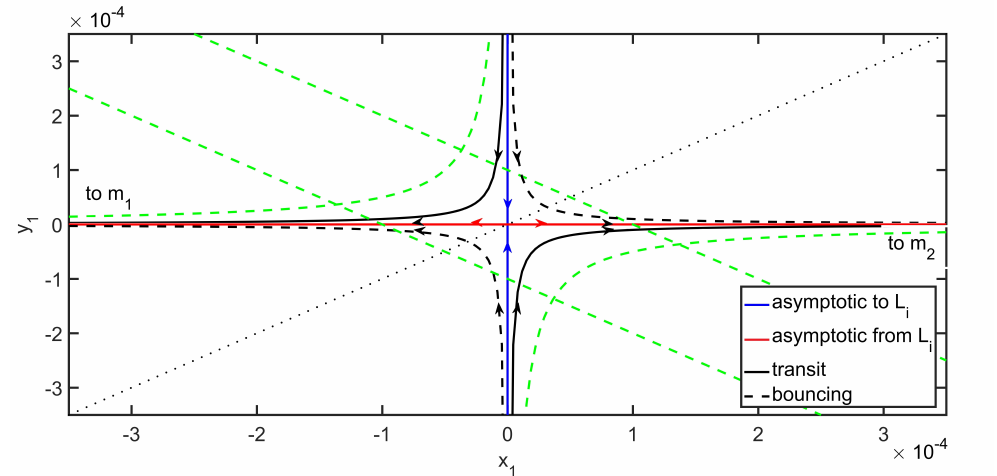
Figure 3. Representation of the phase space flow in ( x 1 , y 1 )